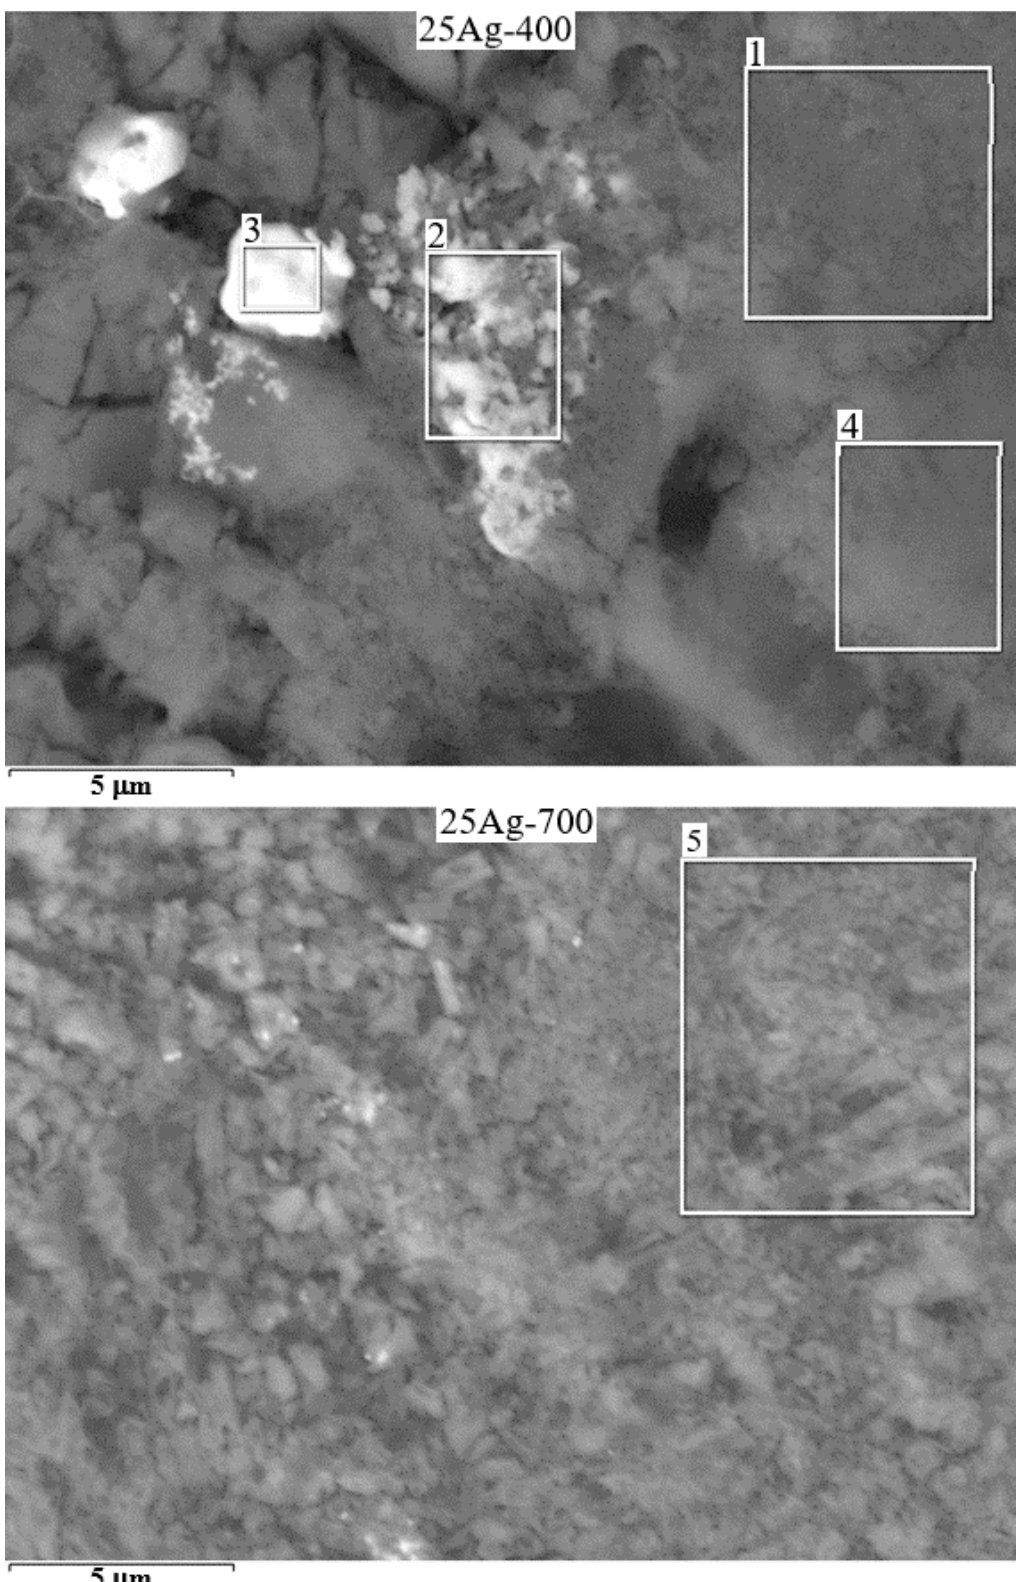
Figure 6. Electron backscattered SEM photographs used for local elemental analyses (presented in Table 2) of the 25Ag-400 and 25Ag-700 samples.